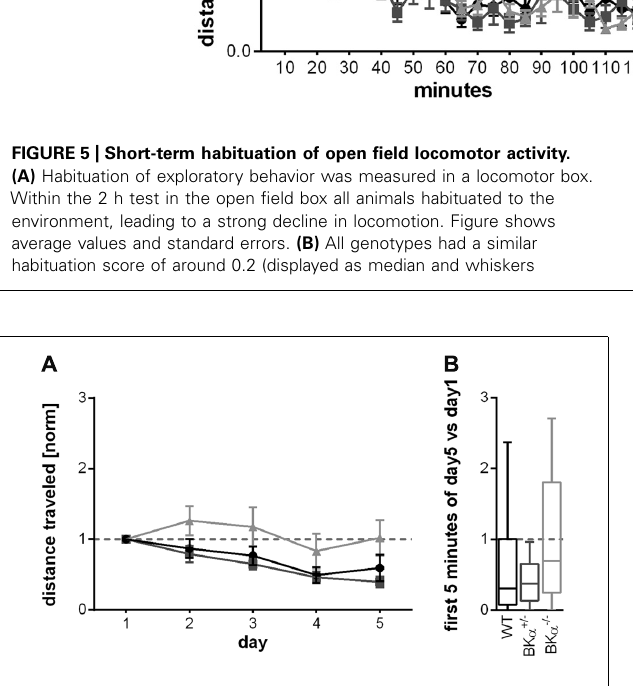
FIGURE 6 | Long-term habituation of open field locomotor activity . (A) Changes in average locomotion across days showed no statistically significant difference between genotypes. Error bars indicate standard errors. (B) The long-term habituation scores (median, with whiskers indicating the 5th and 95th percentile) were also not significantly different between the genotypes. Knock-out animals show a slightly higher score (less long-term habituation), which is mainly due to an initial sensitization on day 2, followed by a